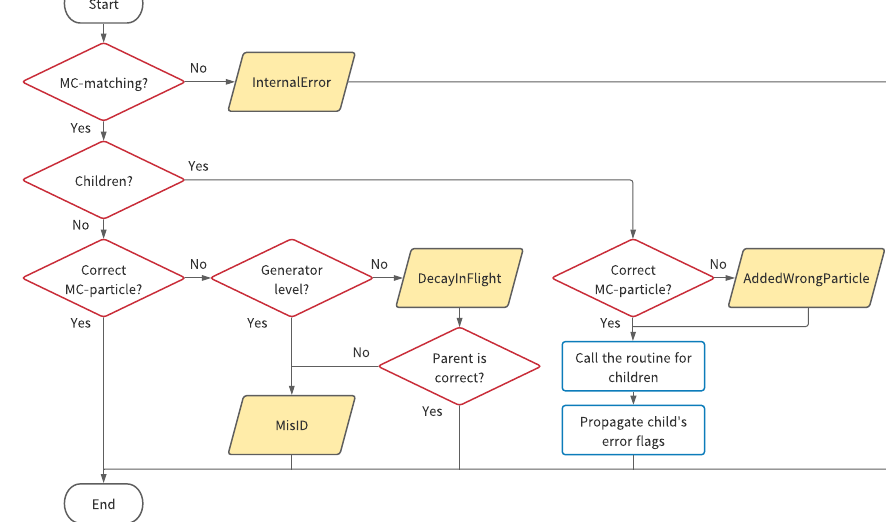
Figure 2. The algorithm flowchart of the evaluation for existing